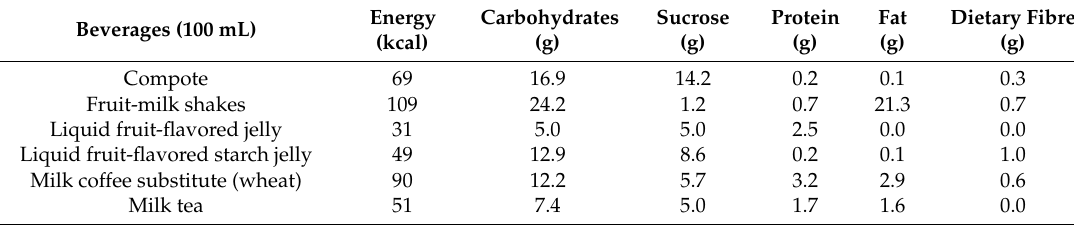
Table 2. The average nutritional value of traditional Polish beverages served in